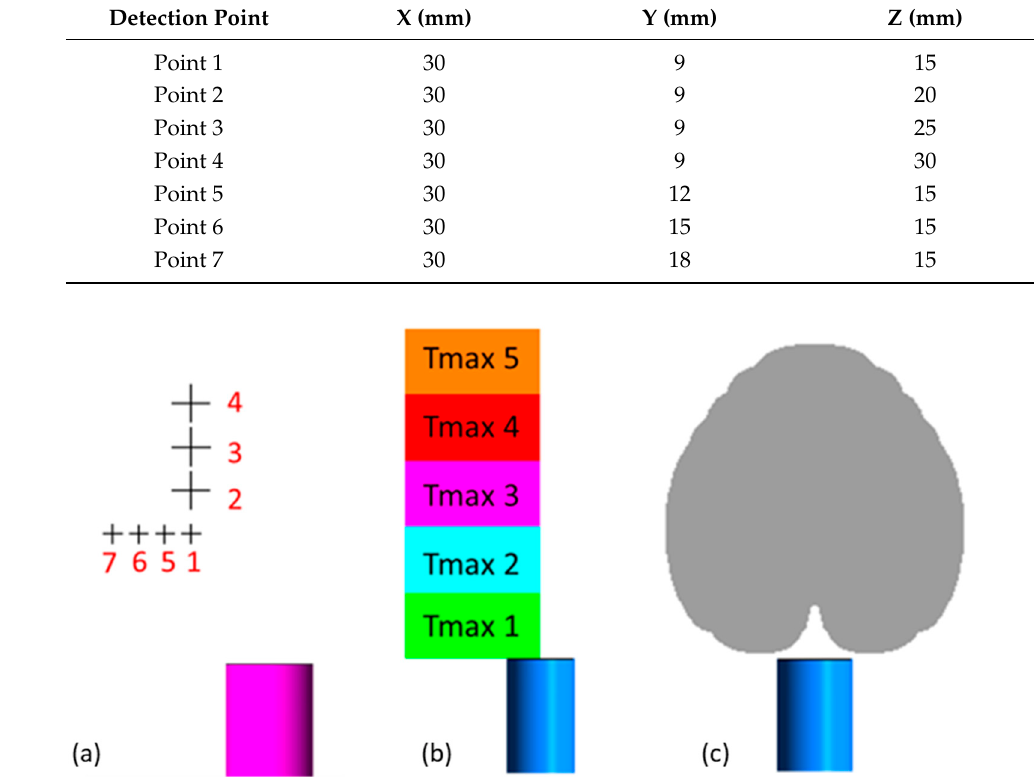
Figure 8. QoI detection zones—( a ) control points set, ( b ) control surfaces set, ( c ) plume area. Table 1. Point probe coordinates.